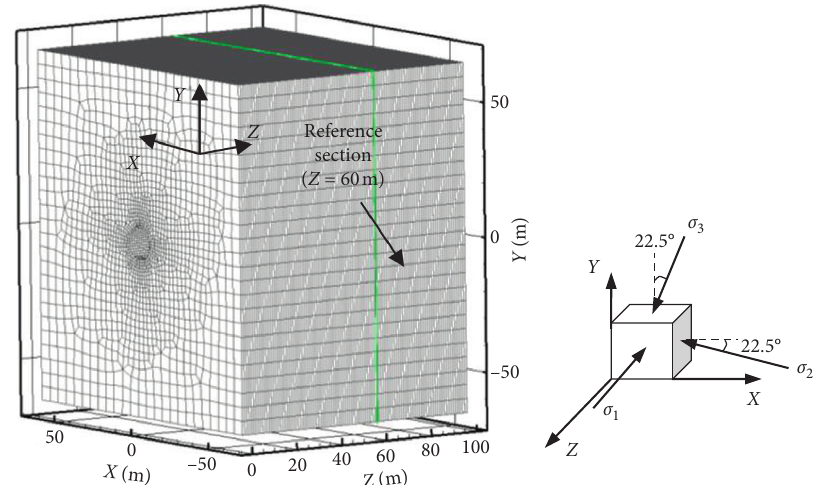
Figure 1: Three-dimensional finite difference mesh, model geometry, and in situ stress-field.